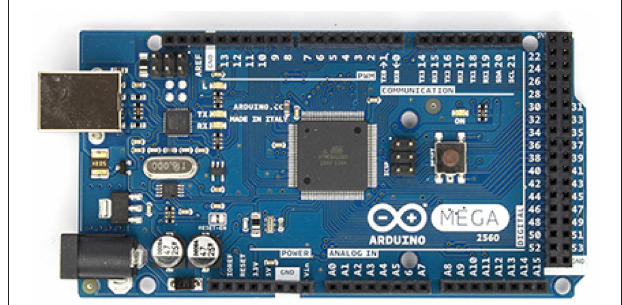
FIGURE 4 | Arduino Mega2560: an electronics prototyping board in Arduino product family.